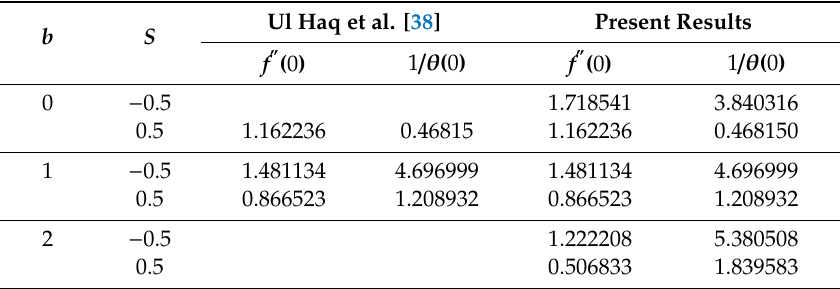
− 1/2 x Nu x under